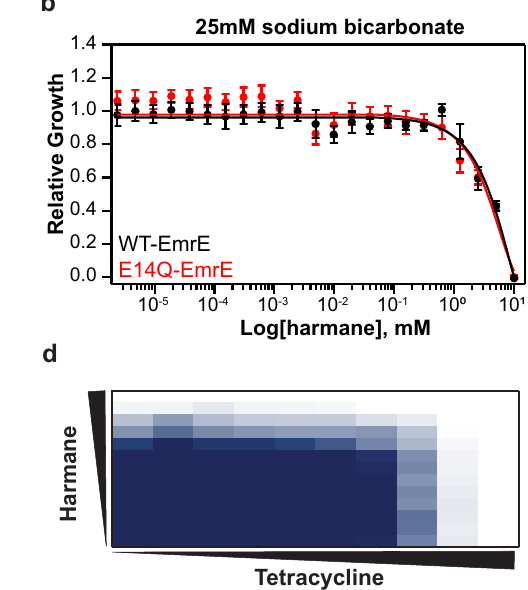
tetracycline ( d ). Growth is shown as a gradient of the highest OD 600 (navy) to no growth (white).The results shown are the average of three biological replicates. In the presenceofharmane, it takes lesskanamycin to reachthe10%growth mark,as indicated by the step pattern in c . This pattern is not seen when harmane is added asanadjuvant to tetracycline. Further, the mean FIC values ofthe experiments are 0.375 (synergistic), and 0.58 (indifferent) for kanamycin and tetracycline,